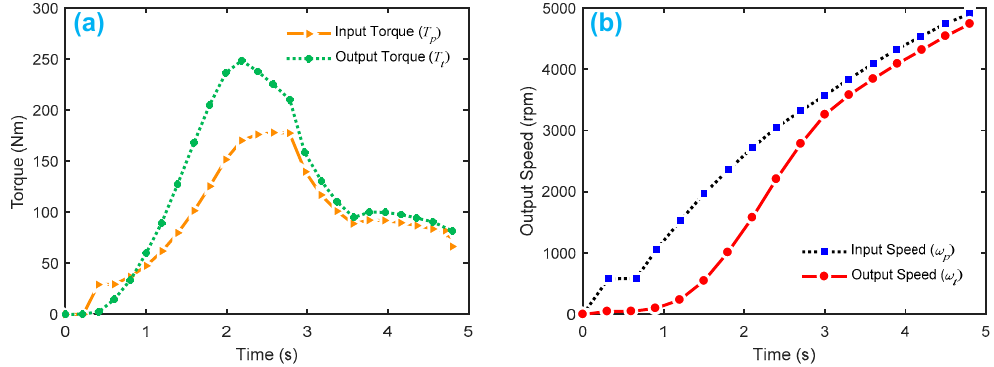
Figure 13. Torque converter characteristics of the HTC in a Honda CRV from Pohl’s paper: ( a ) torque ratio by speed ratio; ( b ) K-factor by speed ratio.